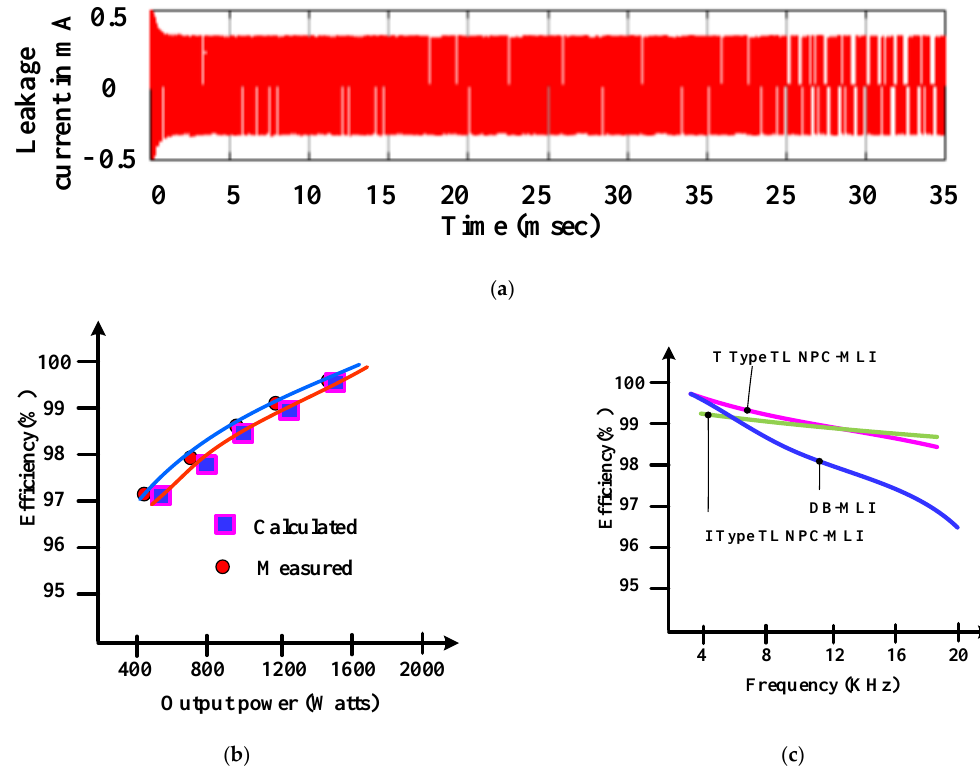
Figure 9. Simulation results. ( a ) Common-mode, i leakage in between inverter and PV module. ( b ) Calculated and measured efficiency of the TNP-MLI prototype. ( c ) Calculated efficiency comparison among TNP-MLI, NPC-MLI, and DB-HBI for Power = 1.5 kVA, V peak = 230 V, I peak = 5 A. Table 4. Comparison of proposed inverter topology with the conventional ones. Inverter Topology.